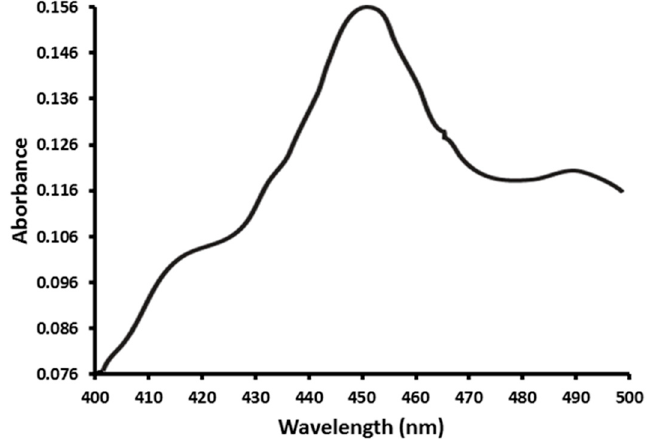
Figure 1. Carbon monoxide difference spectra of microsomes isolated from Sf9-cells recombinantly expressing L. striatellus P450, CYP353D1v2.